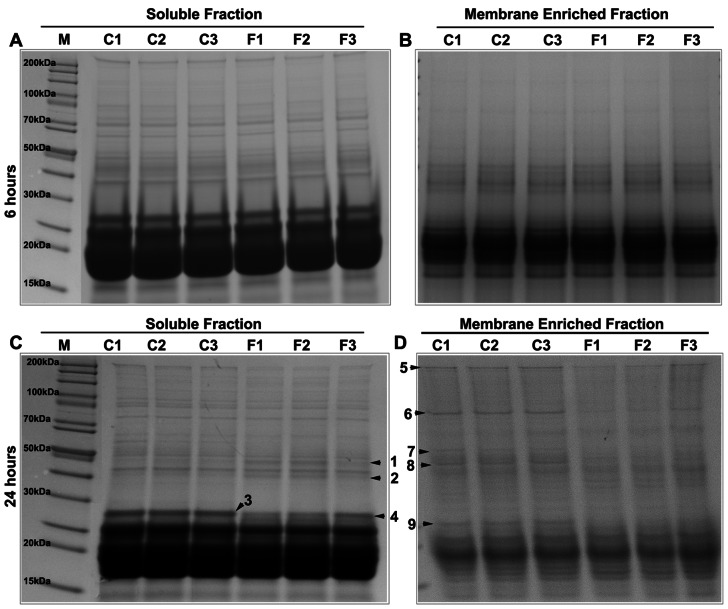
Felodipine-induced changes in protein profile of ex-vivo organ cultured mouse lenses.Felodipine (10 µM for 6 hrs or 24 hrs) and the corresponding DMSO treated control mouse lenses (p21 to P26) were homogenized and separated into soluble (100,000×g supernatant) and insoluble (membrane-enriched) fractions. Equal amounts of protein from soluble (A, C) and insoluble (B, D) fractions were then separated by gradient SDS-PAGE (4–20%) and stained with GelCode blue. Protein bands that exhibited obvious differences in staining intensity between the felodipine treated and control lenses (annotated using numbers and arrowheads in the gel images) were extracted, trypsinized and identified using a Synapt G2 mass spectrometer. See Table 1 for a listing of the proteins identified by mass spectrometry. C1 to C3 and F1 to F3 are individual specimens from control and felodipine treated lenses, respectively.